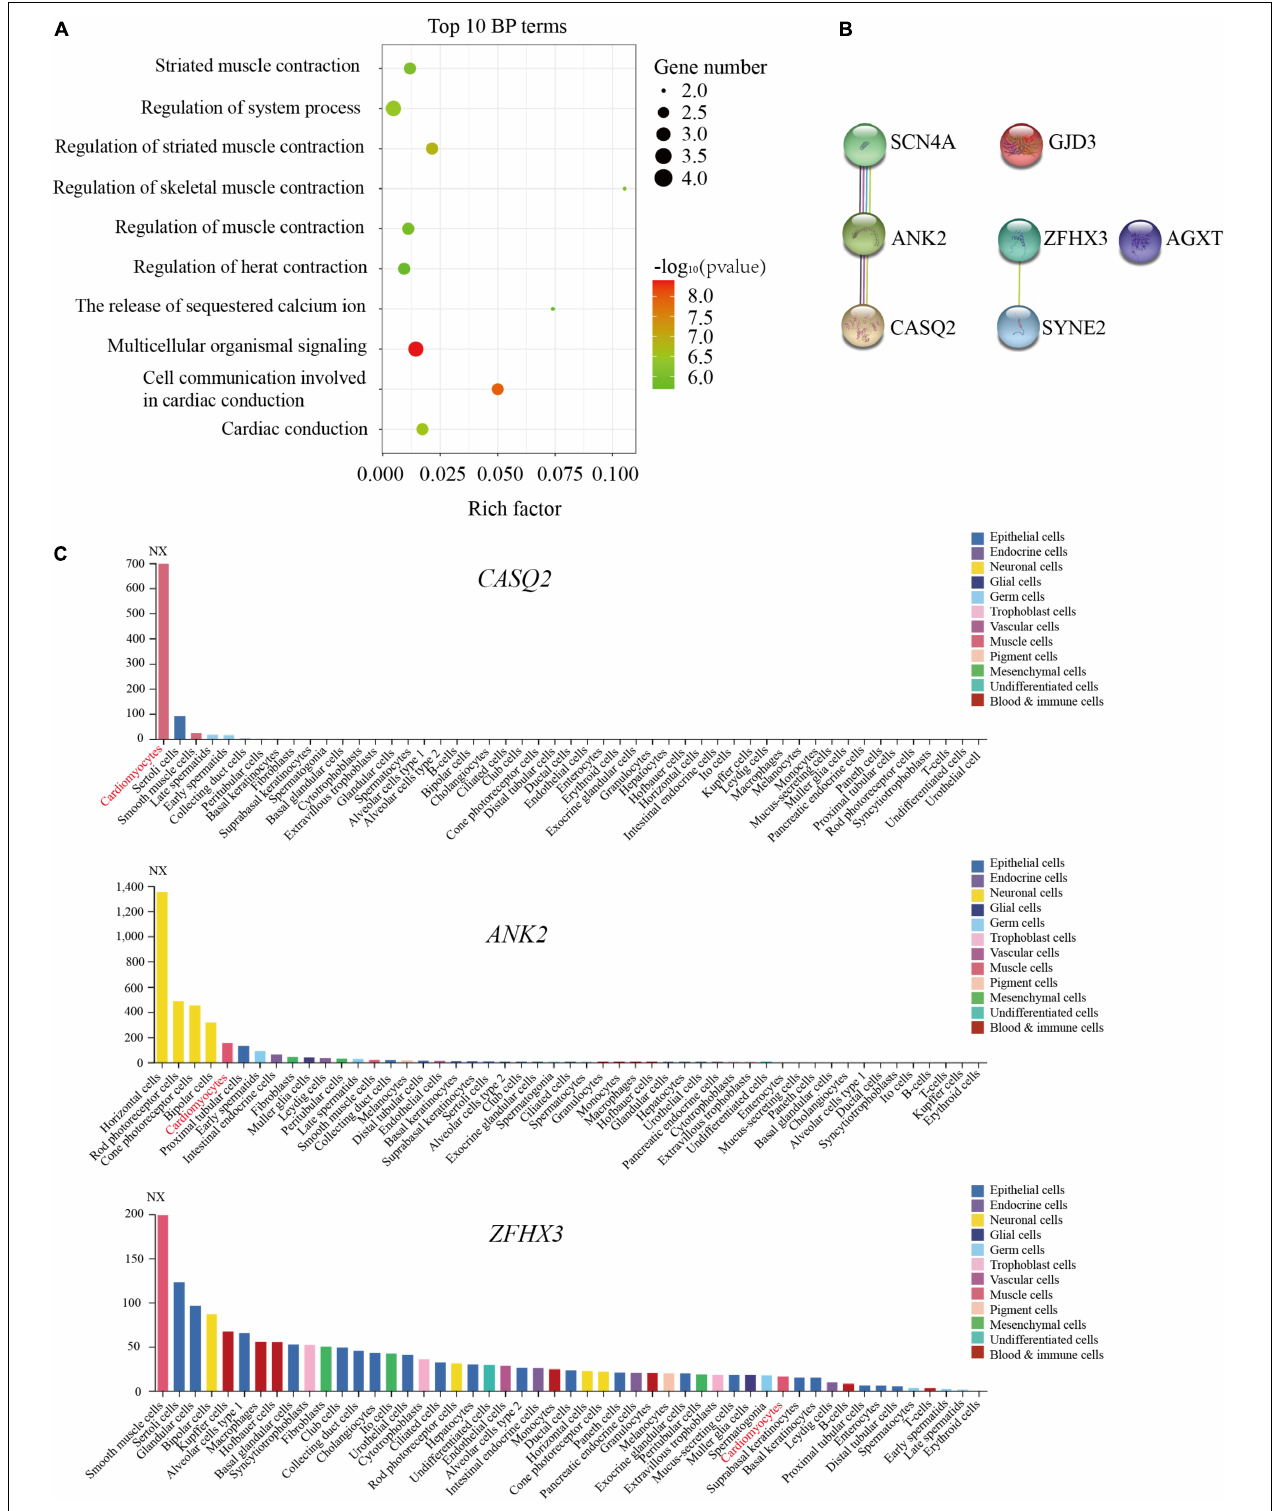
FIGURE 2 | Identification of pathogenic reference genes in familial atrioventricular nodal reentrant tachycardia. (A) The top 10 biological process terms of seven pathogenic genes are depicted using enrichment analysis ( P < 0.05). (B) The protein–protein interactions analysis of seven pathogenic genes. (C) The expression of CASQ2 , ANK2 , and ZFHX3 was shown in different cell types by the single-cell sequencing data.